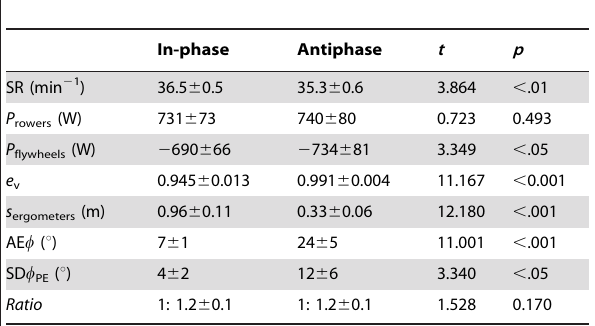
Table 1. Rowing performance in terms of mechanical power, velocity efficiency and interpersonal coordination (mean 6 SD), and paired t-test statistics ( N =8 pairs, df